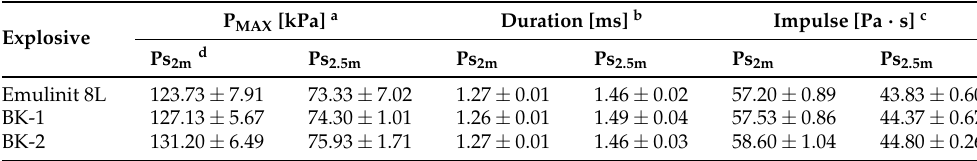
Table 4. Summary of the results of air blast parameter tests. Each value given is the of at least three independent measurements.